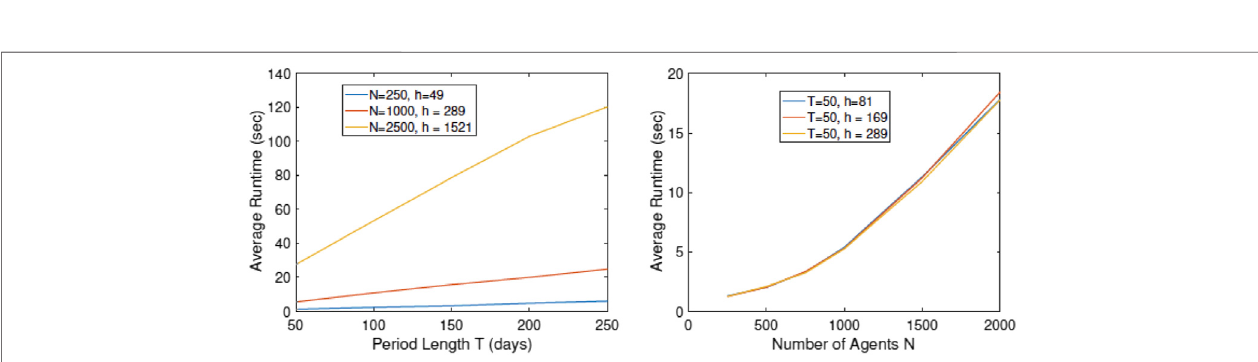
FIGURE 11 | Plots of run times vs. simulation parameters T , N , and h . The algorithmic cost is linear in T but superlinear in N .